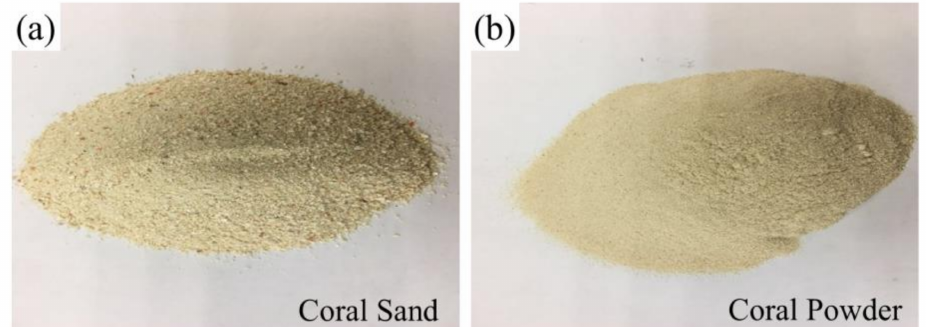
Figure 4. The macro picture of ( a ) coral sand and ( b ) coral powder.